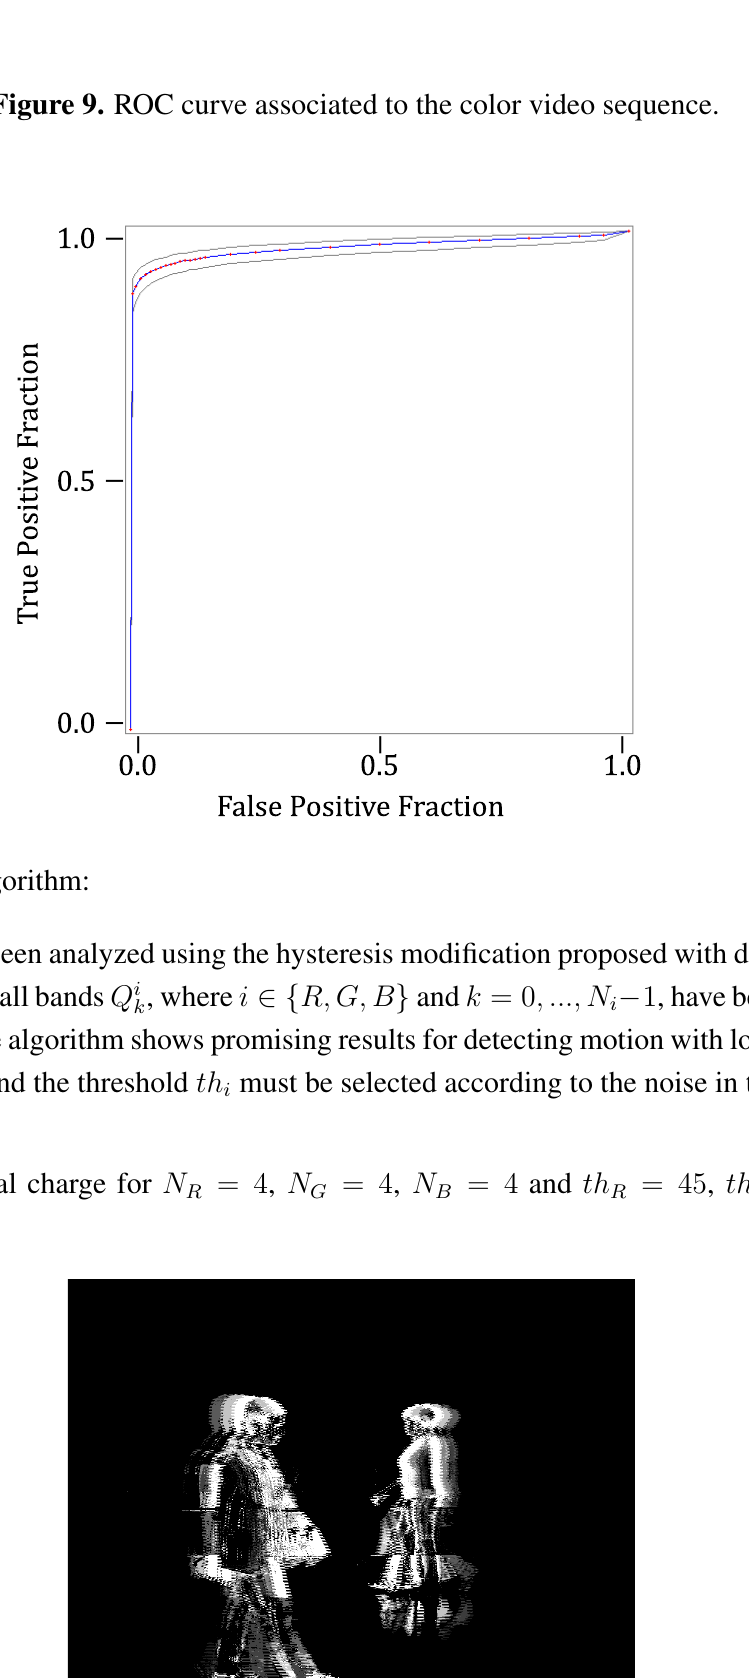
Figure 9. ROC curve associated to the color video sequence.